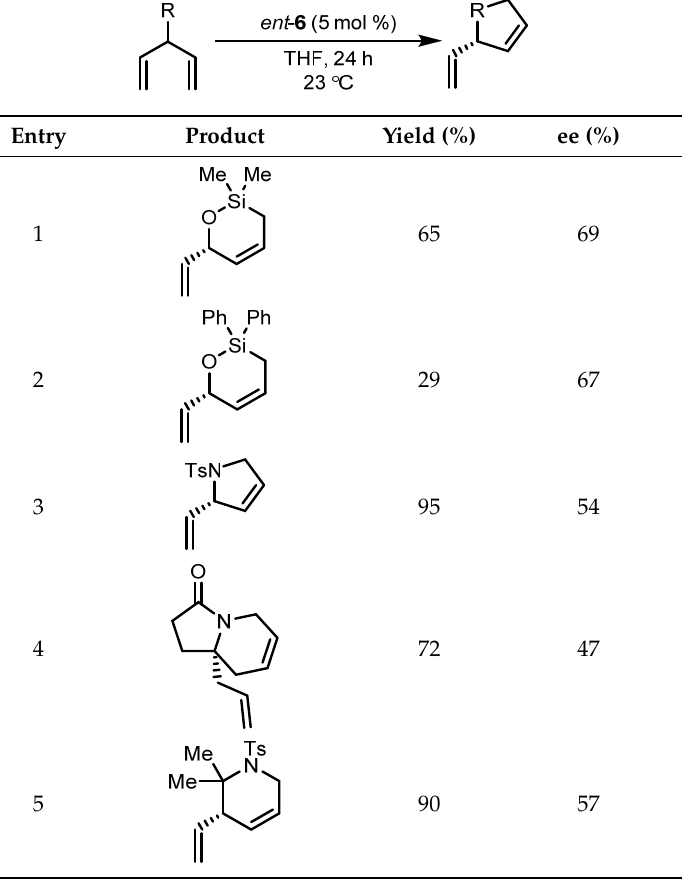
Table 15. Scope of ent - 6 in the ARCM.